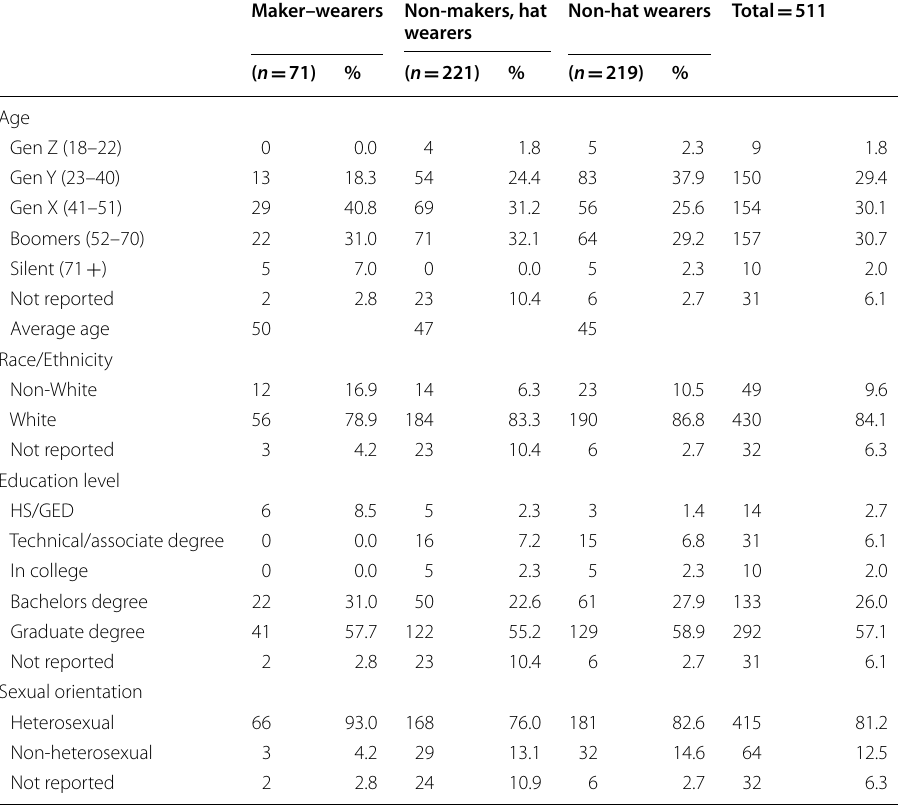
Table 1 Demographics of maker–wearers compared to non-makers wearers and non- wearers Maker–wearers Non-makers, hat Non-hat wearers Total = wearers